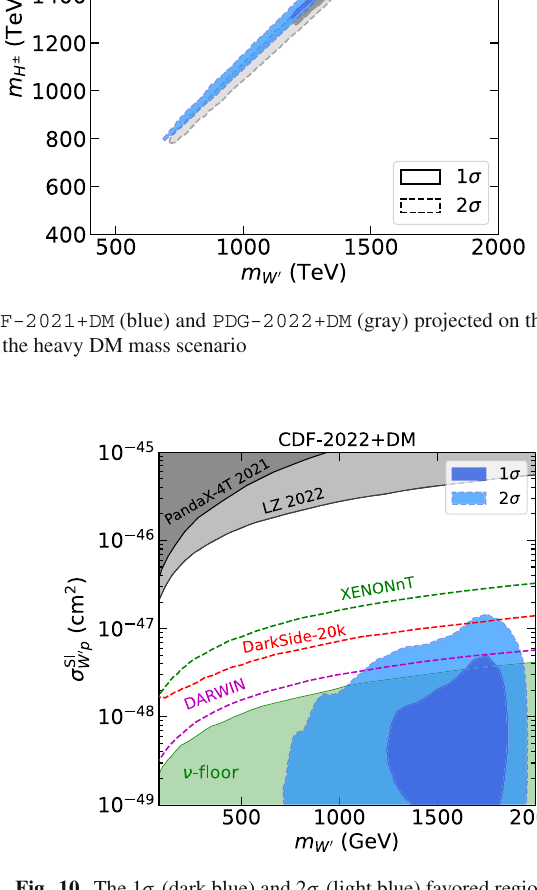
2 σ region, it requires the mass splitting to be in the range of 33 GeV (cid:3) (cid:5) m (cid:3) 78 GeV for PDG-2021+DM and 72 GeV (cid:3) (cid:5) m (cid:3) 100 GeV for CDF-2022+DM . The mix- ing angle is also required to be smaller θ 2 (cid:3) 2 × 10 − 3